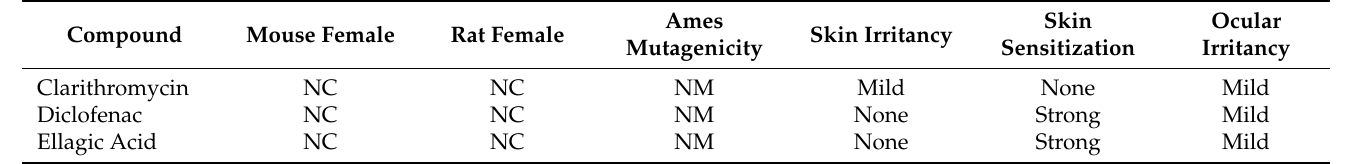
Table 5. Topkat models (Mouse Female, Rat Female, Ames Mutagenicity, Skin Irritancy, Skin Sensiti- zation and Ocular Irritancy) of clarithromycin, diclofenac and Ellagic Acid.